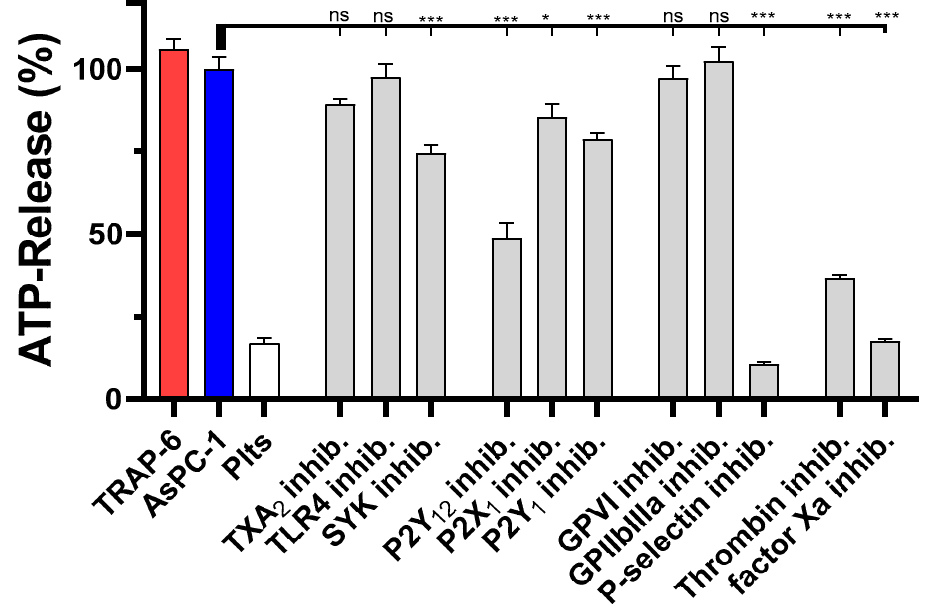
Figure 3. Inhibition of AsPC-1 cell induced platelet dense granule secretion. Quantification of ATP release from resting platelets, platelets co-incubated with 1 × 10 4 AsPC-1 cells, or platelets activated with TRAP-6, respectively, after 20 min. In some experiments platelets were preincubated with inhibitors for TXA2 receptor, TLR4, SYK tyrosine kinase, purinergic receptors P2Y 12 , P2X 1, P2Y 1 , GPVI, GPIIbIIIa, P-selectin, thrombin, or factor Xa, respectively, before the addition of AsPC-1 cells. Data are means of n = 3–5 (±SD), asterisks indicate statistical significance: * p < 0.05; *** p < 0.001.